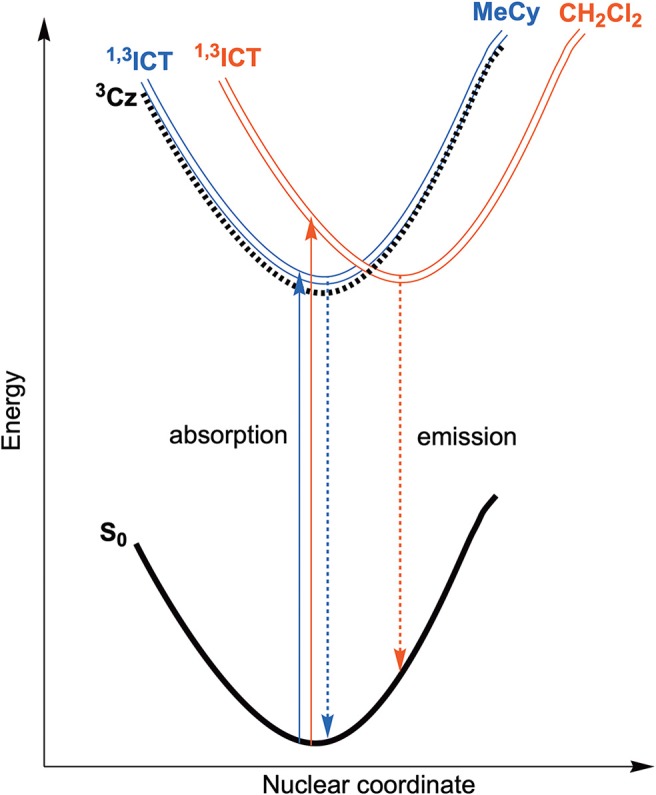
Qualitative energy diagram representing the ground state (S0) and both excited state potential energy surfaces (3Cz and 1,3ICT) as a function of nuclear coordinate in MeCy (blue) and CH2Cl2 (red) solution along with absorption (solid) and emission (dashed) transitions.